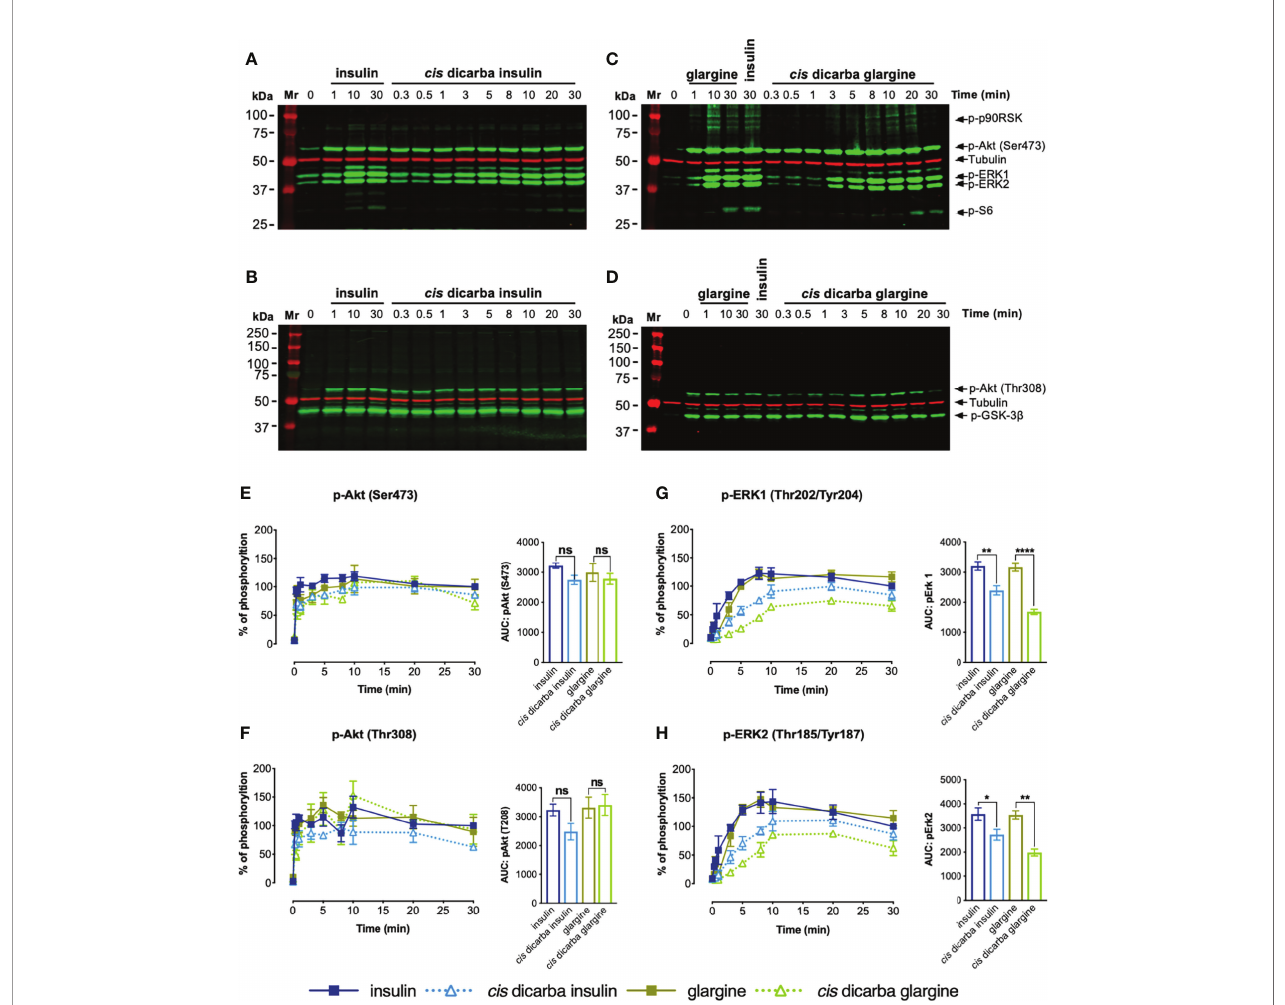
FIGURE 5 | Cis- dicarba insulin and cis- dicarba glargine insulin exhibit time-dependent signaling bias via IR-A overexpressing cells. Serum starved IR-A overexpressing L6 myoblasts (hIR-A L6) were stimulated with 10 nM of (A, B) insulin or cis- dicarba insulin or (C, D) glargine or cis- dicarba glargine in a time-course of t = 0, 0.33 (20 s), 0.5 (30 s), 1, 3, 5, 8, 10, 20 and 30 min. The full time-course of insulin and glargine can be seen in Figure S6 . (E-H) : Quantitation of western blots (n = at least 3 independent experiments). Phosphorylation levels are expressed as percentage of level detected when cells were stimulated with 10 nM of insulin for 30 min; normalized to b -tubulin: (E) Akt (phosho-Ser473), (F) Akt (phosho-Thr308), (G) ERK 1 (phospho-Thr202/Tyr204) and (H) ERK2 (phospho-Thr185/ Tyr187). All data are the mean ± S.E.M. Error bars are shown when greater than the size of the symbols. AUC, area under the curves derived from % of phosphorylation over 30 minutes. Statistical signi fi cance of the difference in total phosphorylation over 30 minutes measured as AUC when stimulated by cis- dicarba insulin compared to insulin or cis- dicarba glargine compared to glargine insulin were determined via ordinary one-way ANOVA. ns: non-signi fi cant; * (P ≤ 0.05), ** (P ≤ 0.01); *** (P ≤ 0.001); **** (P ≤ 0.0001). Quantitation of other phosphorylated proteins are included in Figure S7